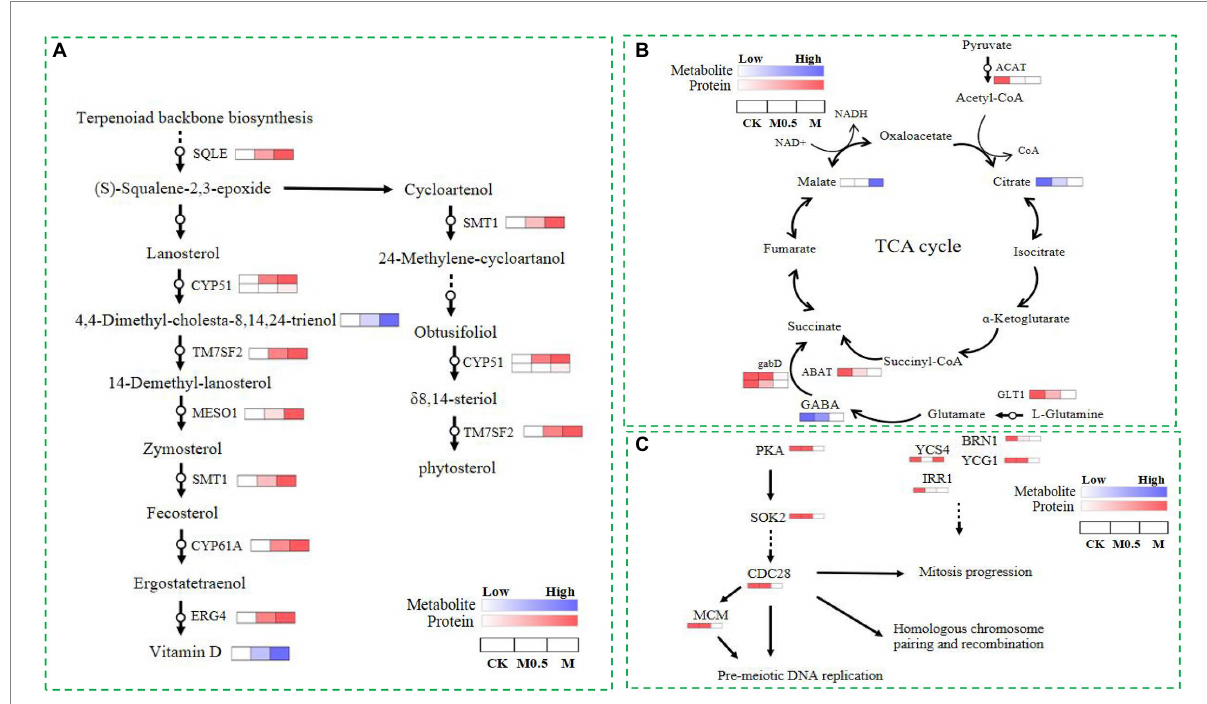
FIGURE 8 Differential proteins and metabolites involved in steroid biosynthesis (A) , the TCA cycle (B) and the cell cycle and meiosis (C) in CK, M0.5 and